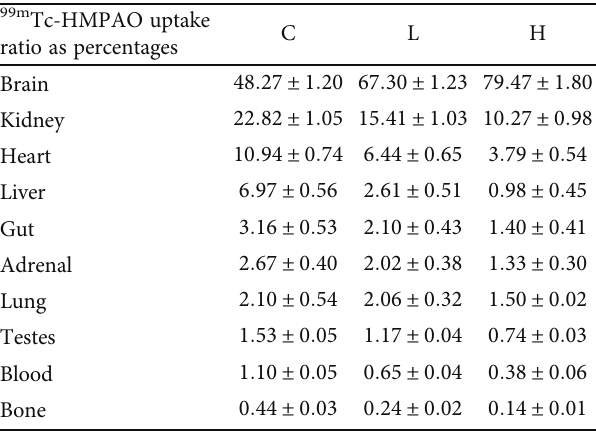
Activity in resected organs, normalized and corrected by background counts and whole-body radioactivity. The values are expressed as percentages. ∗ p value is 0.69 by ANOVA (the f -ratio value is